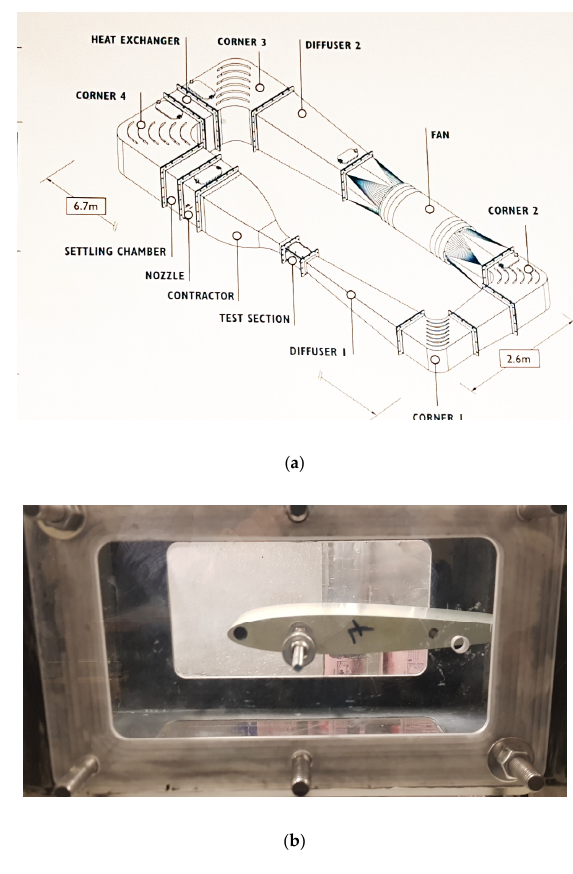
Figure 1. ( a ) Schematic of the icing wind tunnel; ( b ) NACA 0012 profile mounted in icing wind tunnel test section. Ice reduction was calculated from the obtained ice accretion values using formula: accreted ice for Sample X (cid:4679) Ice reduction = 100%× (cid:4678) 1 (cid:3398) accreted ice for Reference Sample 3. Results 3.1. Synthesis of Trifunctional POSS ‐ Based Compounds POSS ‐ based compounds were prepared according to the synthesis procedure de ‐ scribed in Section 2.1.1. They were investigated by NMR and FT ‐ IR spectroscopy to prove the completion of the reactions (the disappearance of the characteristic signal was ob ‐ served at 2141 and 889 cm − 1 , respectively, due to the stretching and bending of the Si ‐ H